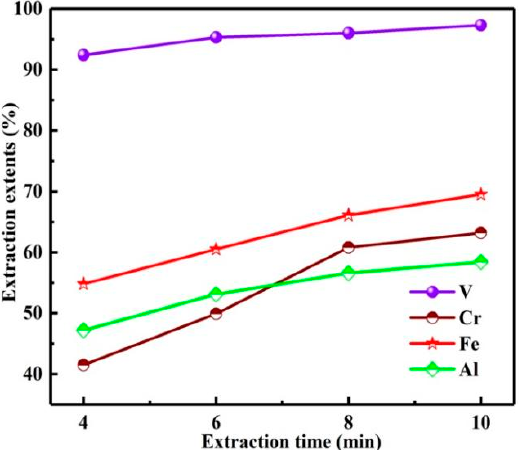
Figure 12. Influence of extraction time on extraction